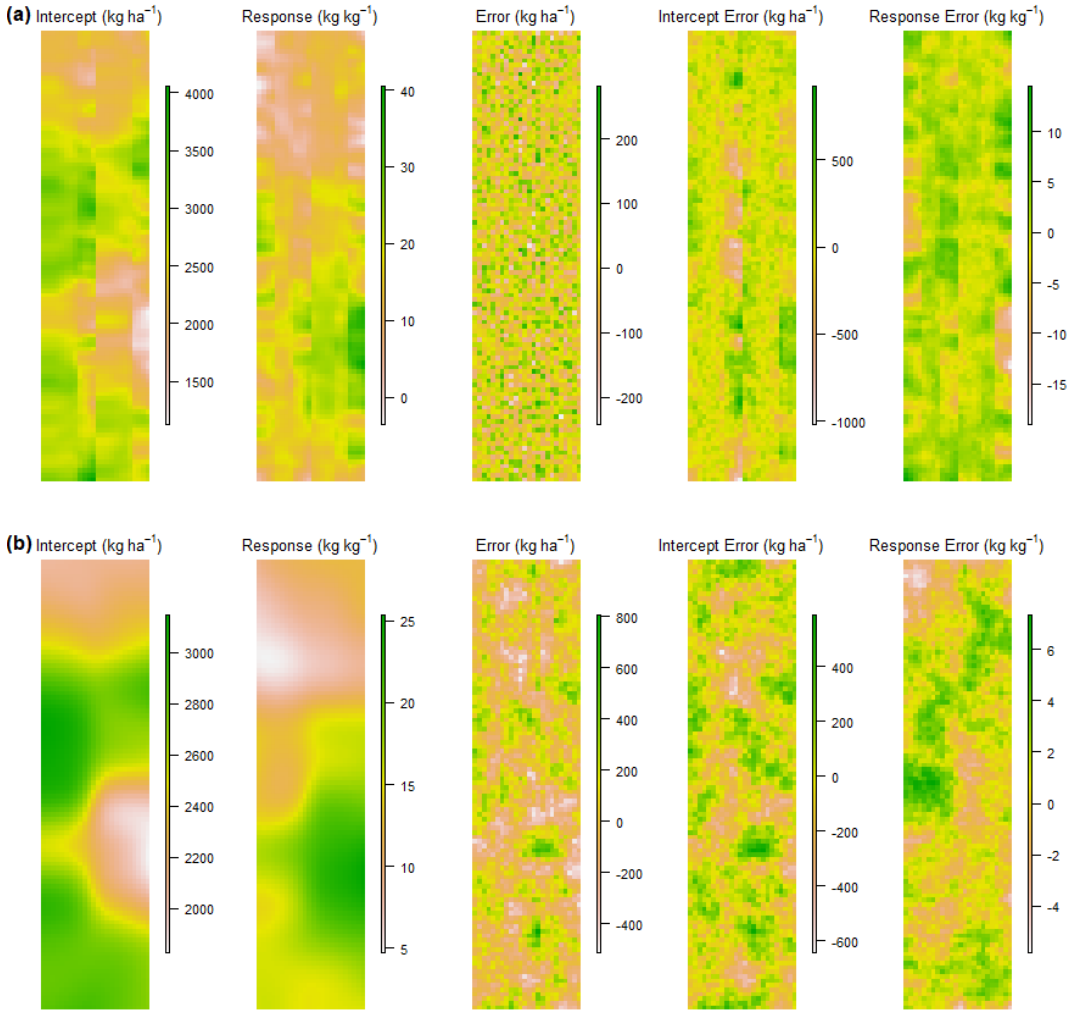
Figure 8. Results for data simulated with locally varying linear response using bandwidth selection by ( a ) minimal AICc and ( b ) based on experimental design.